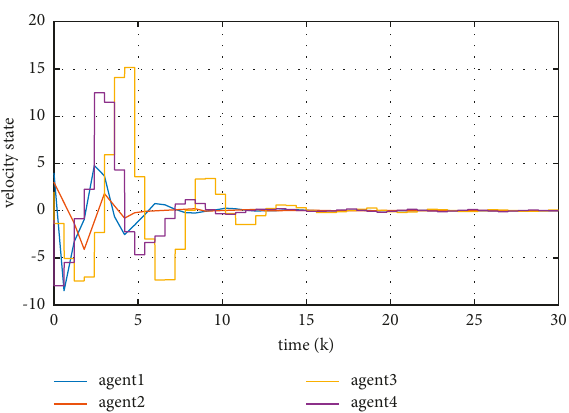
Figure 3: Velocity of the second-order dynamic